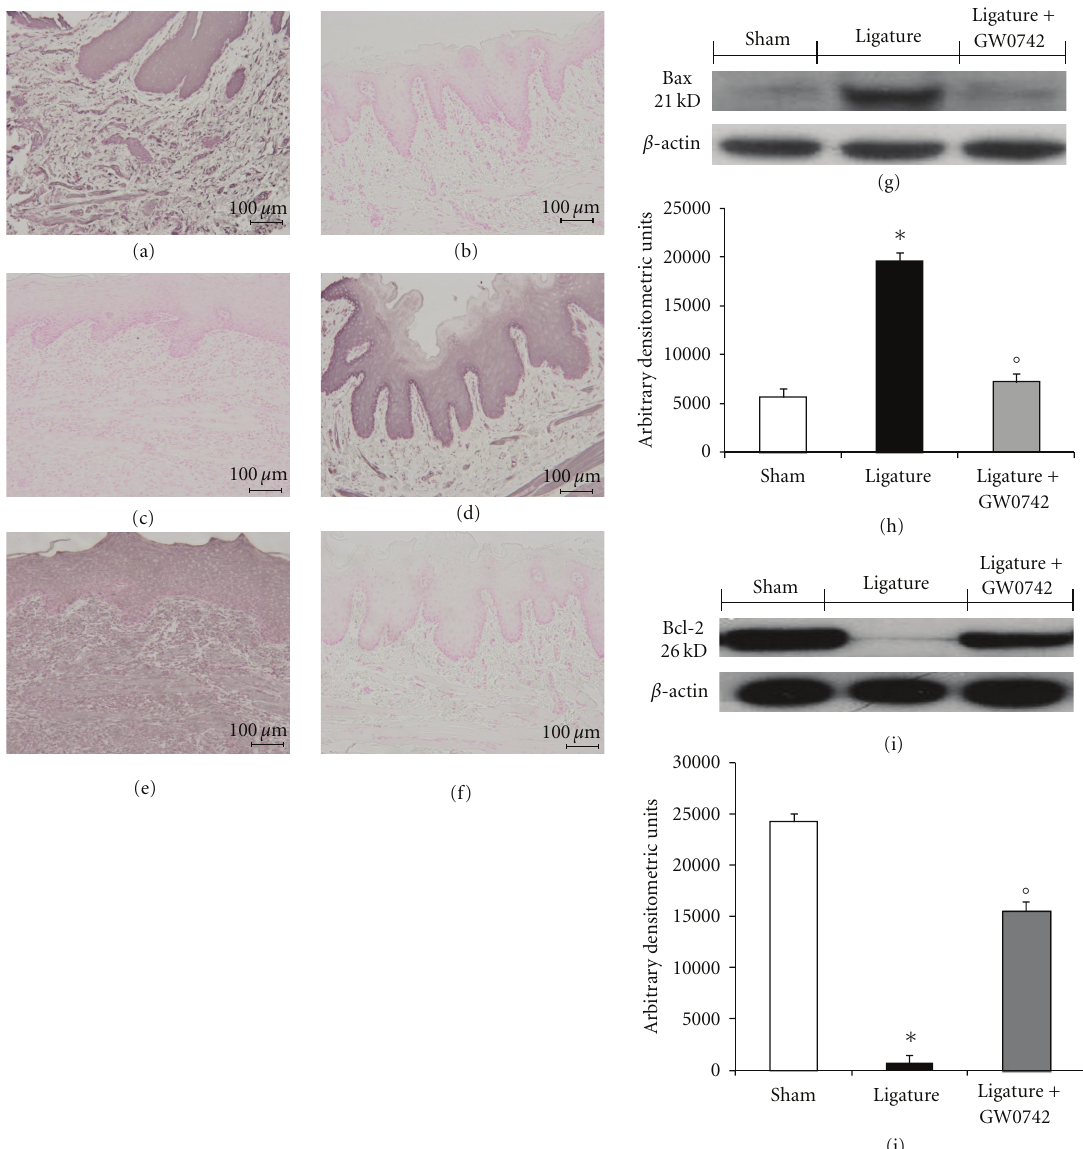
Figure 5: E ff ects of GW0742 on apoptosis. Immunohistochemistry for Bax and Fas-L showed positive staining in the gingivomucosal sections after ligature (a, e). The degree of positive staining for Bax and Fas-L was markedly reduced in GW0742-treated rats (b, f). Moreover, the degree of positive staining for Bcl-2 was markedly reduced in gingivomucosal sections obtained after ligature (c). The reduction of Bcl- 2 expression was significantly attenuated by GW0742 treatment (d). In western blot analysis, basal level of Bax was present in the tissue from sham-operated rats (g, h). Bax band is more evident in the tissue from ligature-treated rats (g, h). The Bax band disappeared in the tissue from GW0742 treated (g, h). Moreover, a basal level of Bcl-2 was present in the tissue from sham-operated rats (i, j). The Bcl-2 band disappeared in the tissue from rats subjected to ligation (i, j). The Bcl-2 band is more evident in the tissue from ligated rats that received GW0742 (i, j). This figure is representative of at least 3 experiments performed on di ff erent experimental days. A representative blot of lysates obtained from 5 animals per group is shown, and densitometry analysis of all animals is reported. The results in (h, j) are expressed as mean ± S.E.M. from n = 5 / 6 gingivomucosal tissues for each group. ∗ P < 0 . 01 versus nonligated group. ◦ P < 0 . 01 versus ligated group.